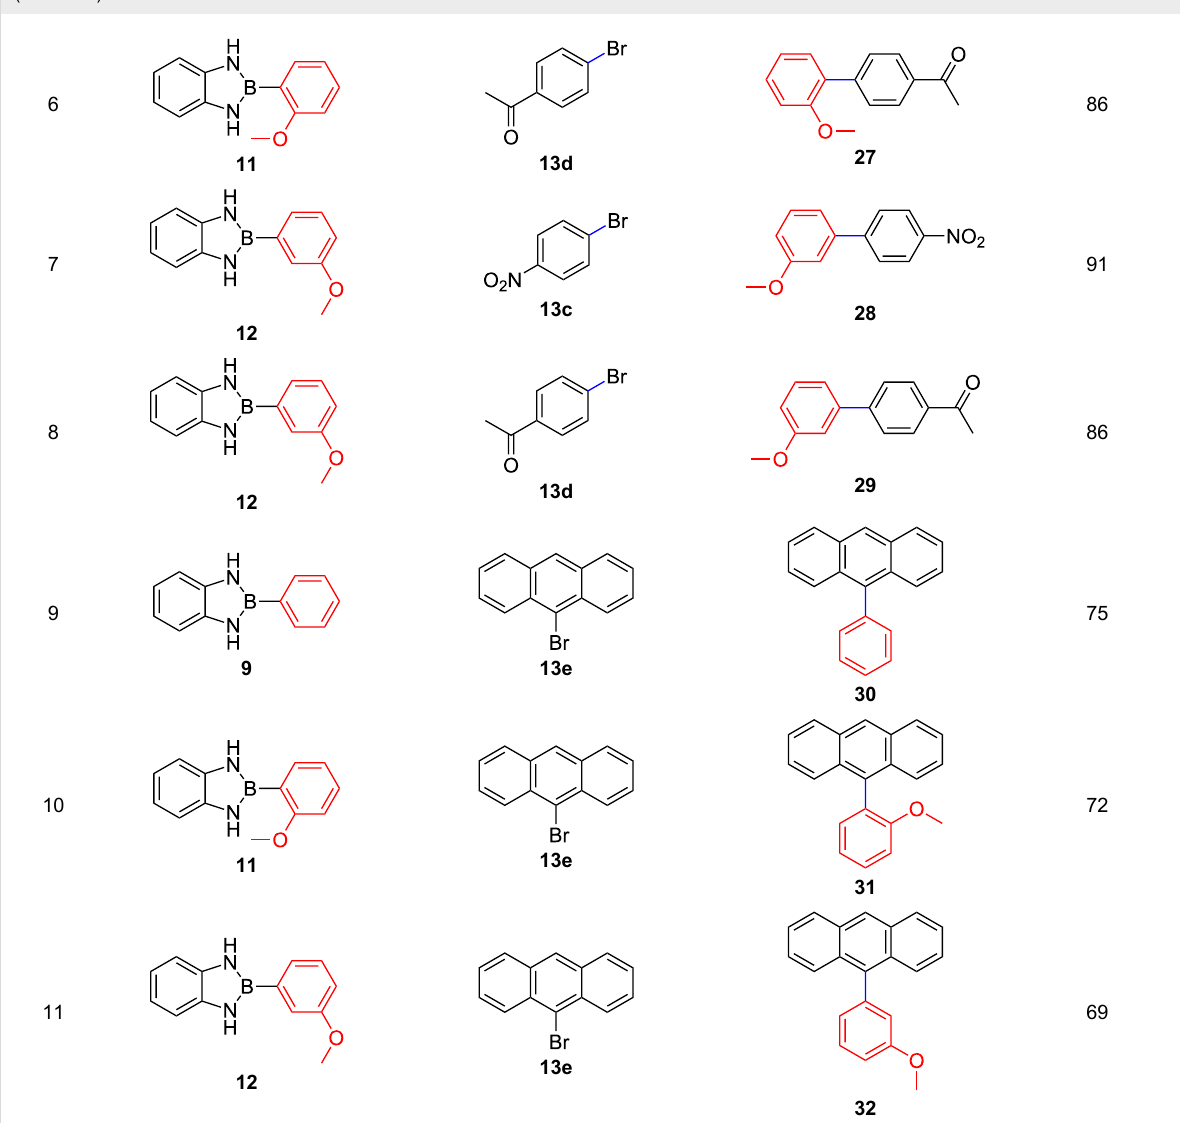
Table 3: Palladium-catalysed cross-coupling of boronate 9 – 12 with 4-bromonitrobenzene, 4-bromoacetophenone and 9-bromoantracene. a